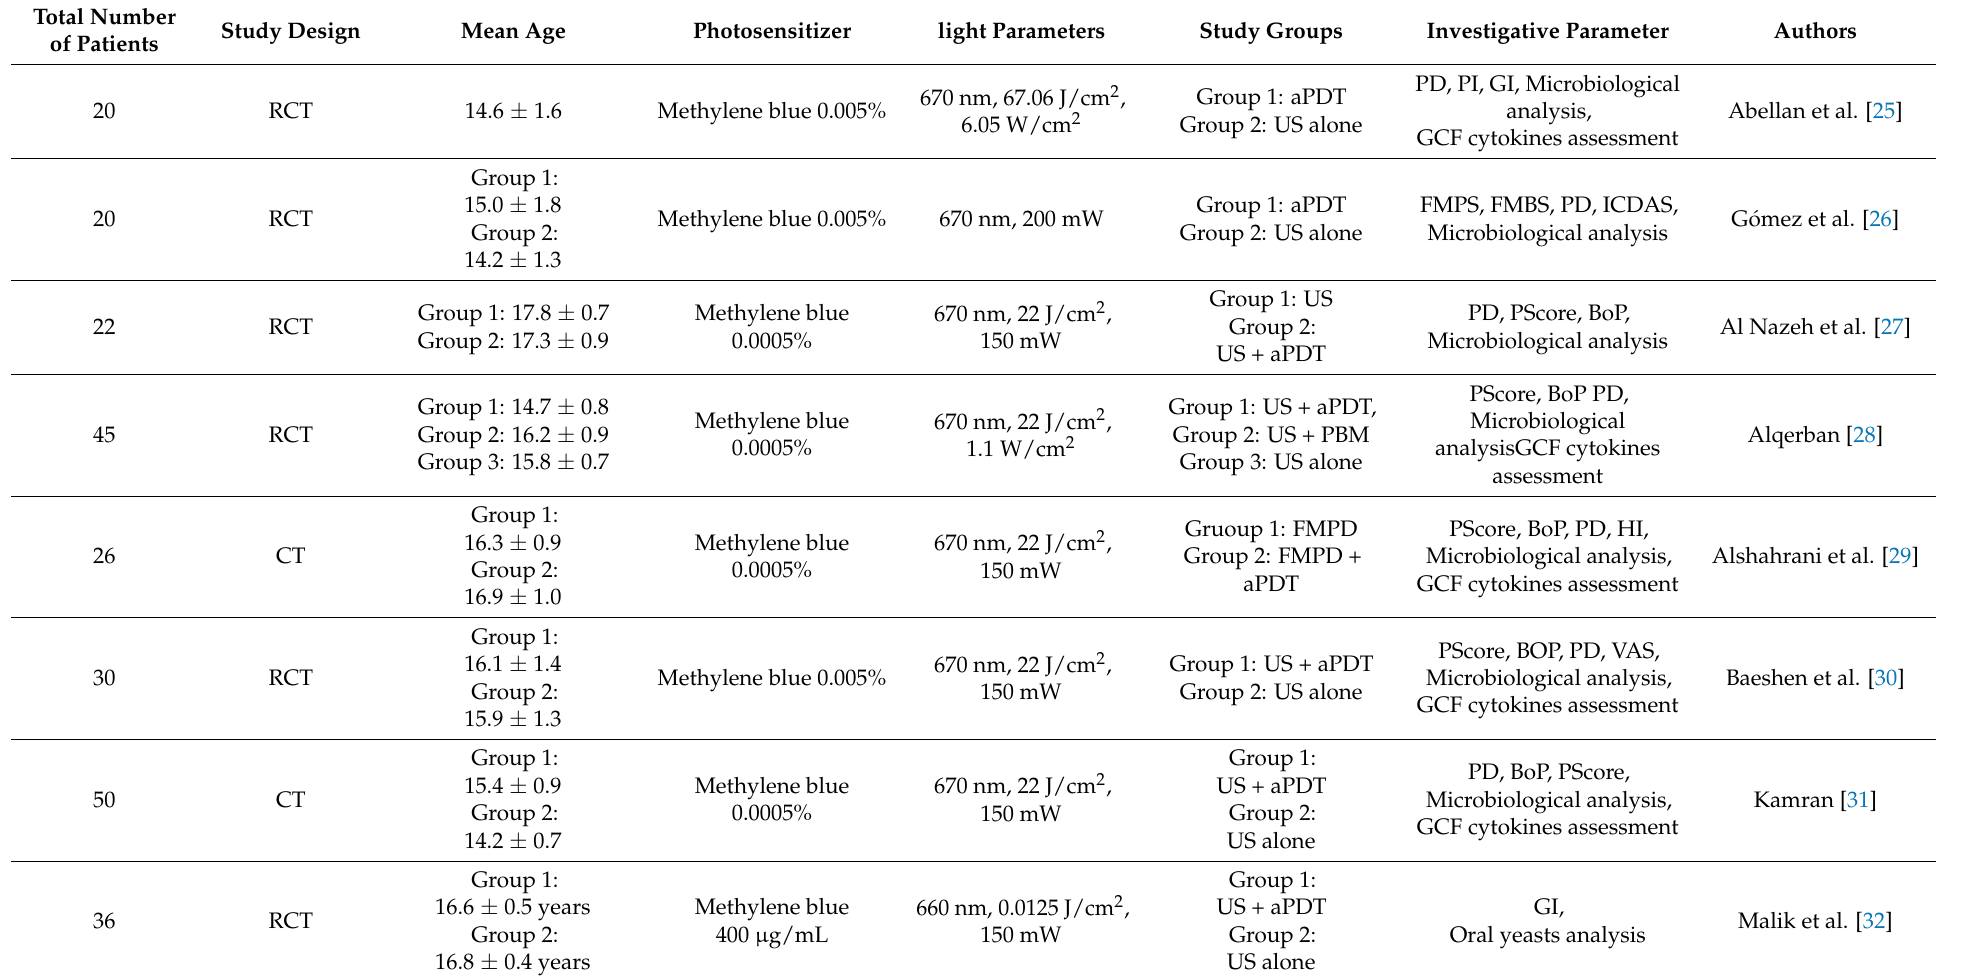
Table 1. Photodynamic therapy in clinical